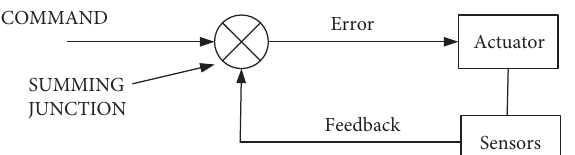
Figure 3: Working principle of the closed-loop control